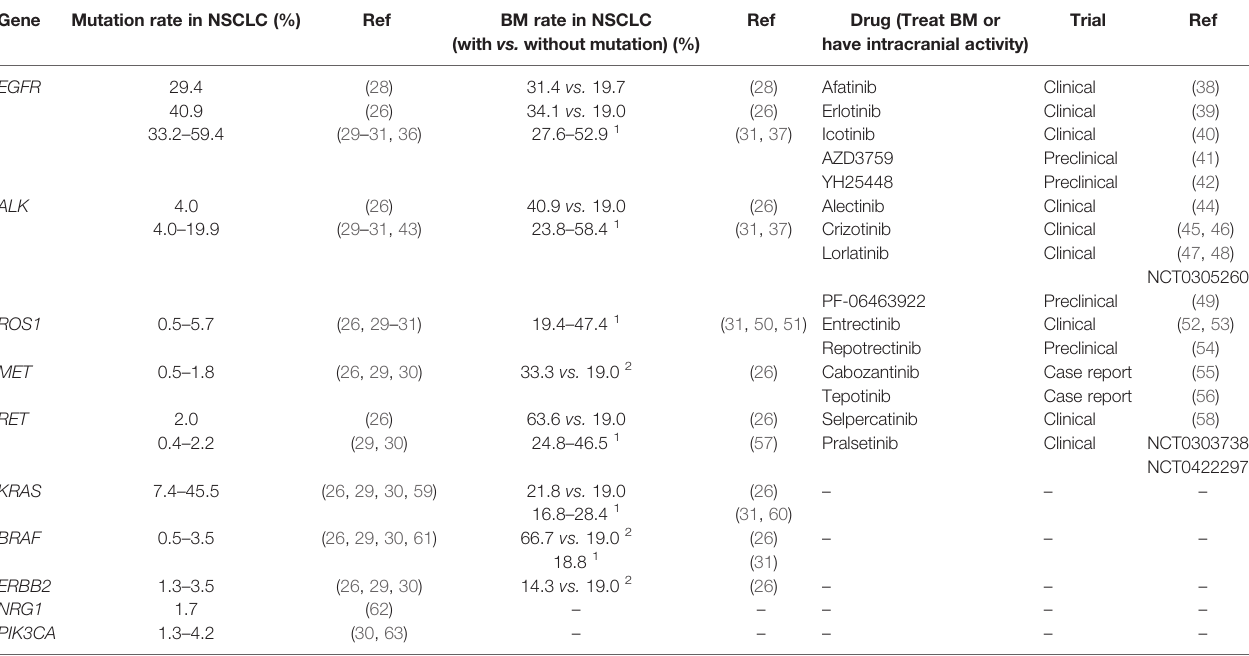
TABLE 2 | Potential biomarkers in lung cancer driver genes and the targeted drugs in brain metastasis. Gene Mutation rate in NSCLC